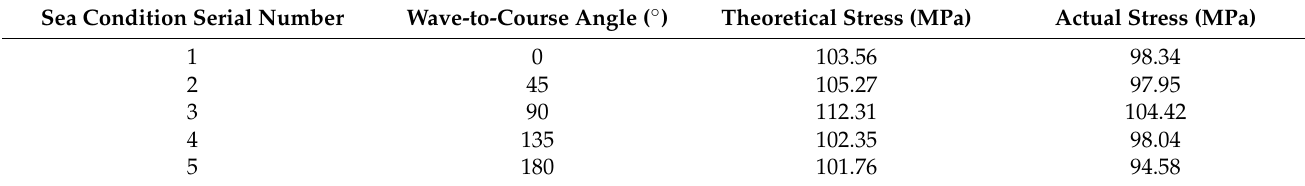
Table 10. Maximum stress of upper connecting rod of tensioner at initial adjustment.